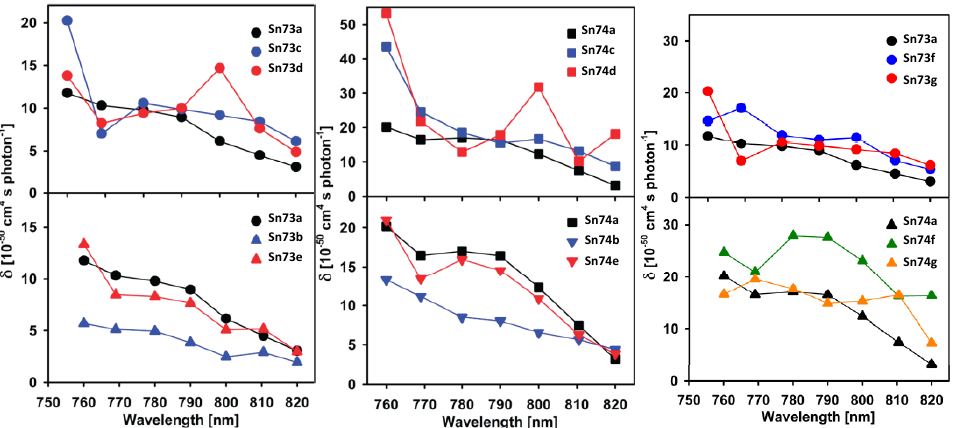
Figure 55. TPA spectra for diphenyl tin(IV) complexes Sn73a–g and Sn74a–g , (Adapted with